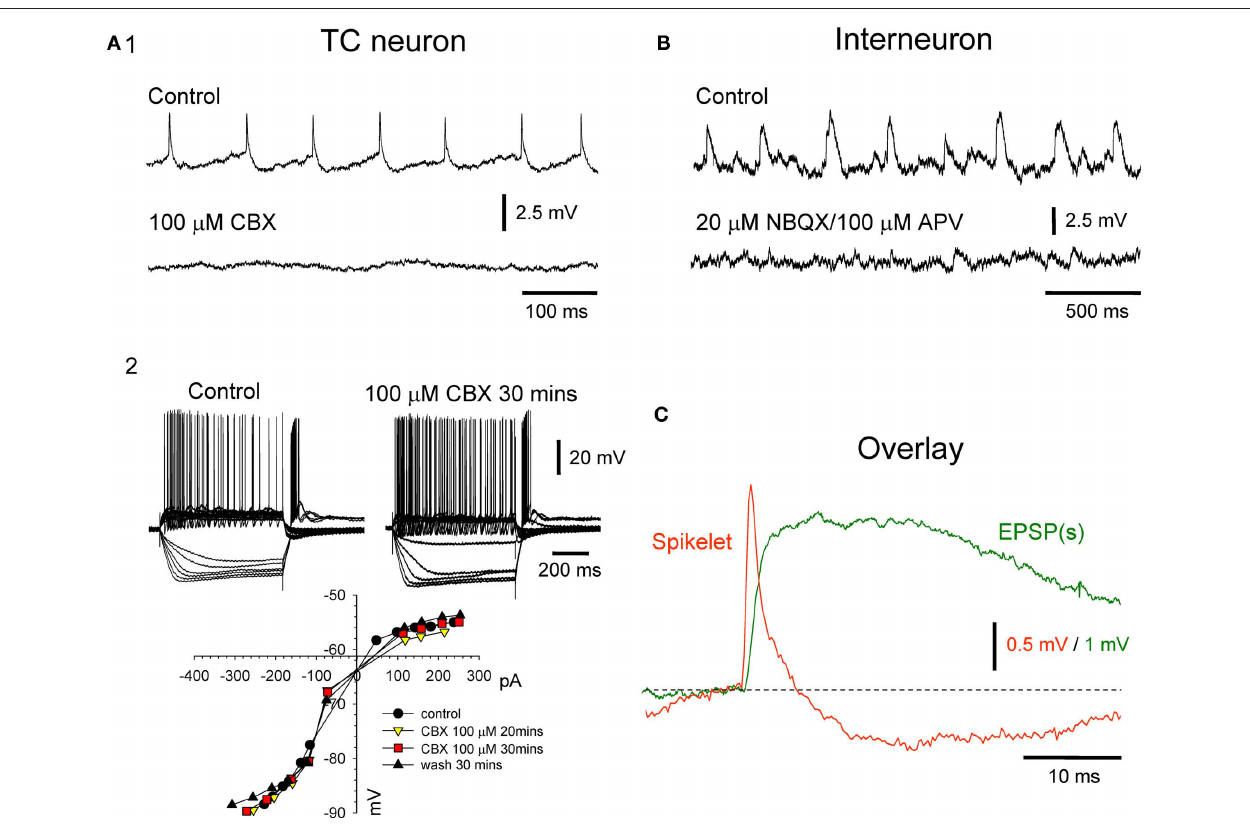
FiGurE 6 | Presence of spikelets in TC neurons and their absence in local circuit interneurons. (A1) Intracellular recording from an LGN TC neuron showing the presence of spikelets (top) and their abolition by 100 μM CBX (bottom). (A2) Voltage responses of a different LGN TC neurons to a series of injected current steps in control conditions (top left and 30 min after application of 100 μM CBX (top right). The current– voltage plot below shows that CBX has no effect on basic membrane